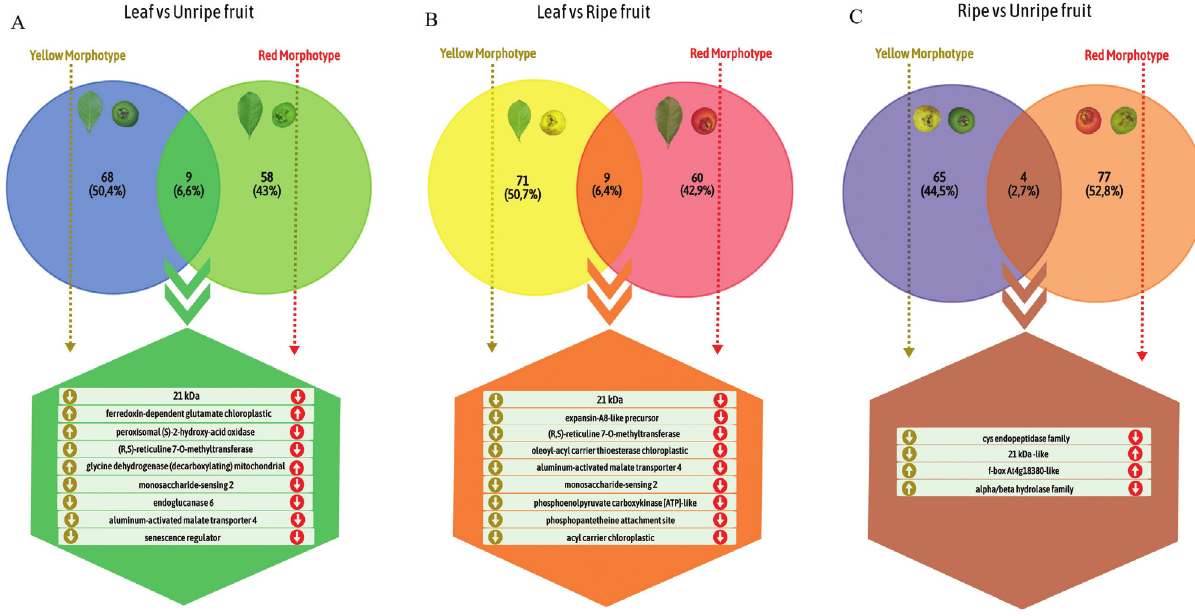
Figure6 -Venndiagramsshowingclusterssharedamongthedifferenttissuesofeachmorphotypeof P.cattleyanum .Eachcomparisondisplaystheanno- tation shared. The arrows indicate the different regulation (up- and down-regulated) for each